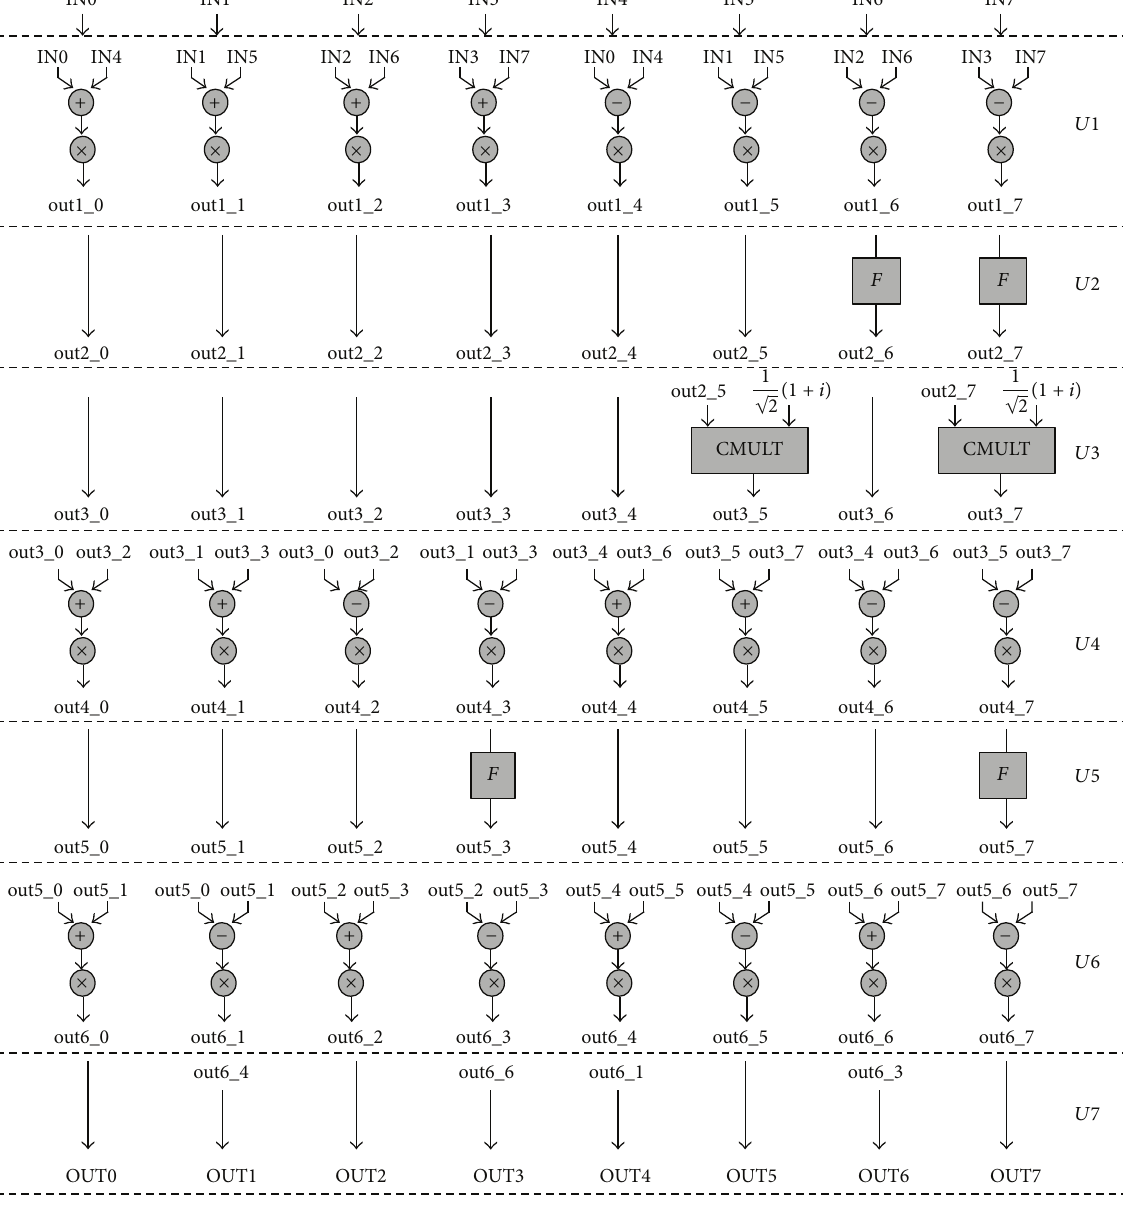
Figure 10: Data-flow graph for 3-qubit QFT. The multipliers shown in this diagram represent the multiplication of input complex number with constant 1/√2